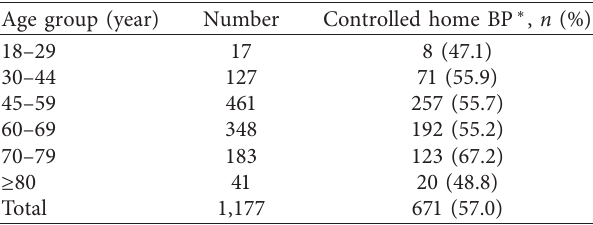
Table 2: Home blood pressure control rate for different age groups †